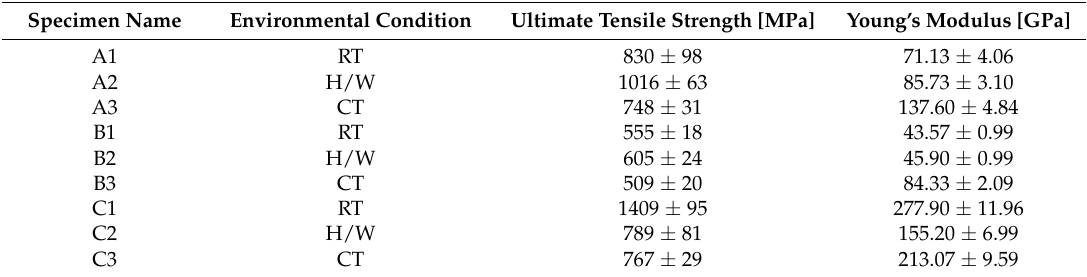
Table 2. Mechanical test results for specimens tested under different environmental